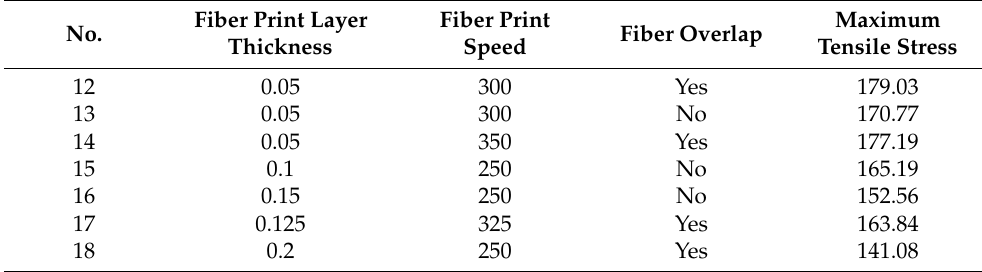
Table 6. Test table of fiber print layer thickness, fiber print speed, fiber